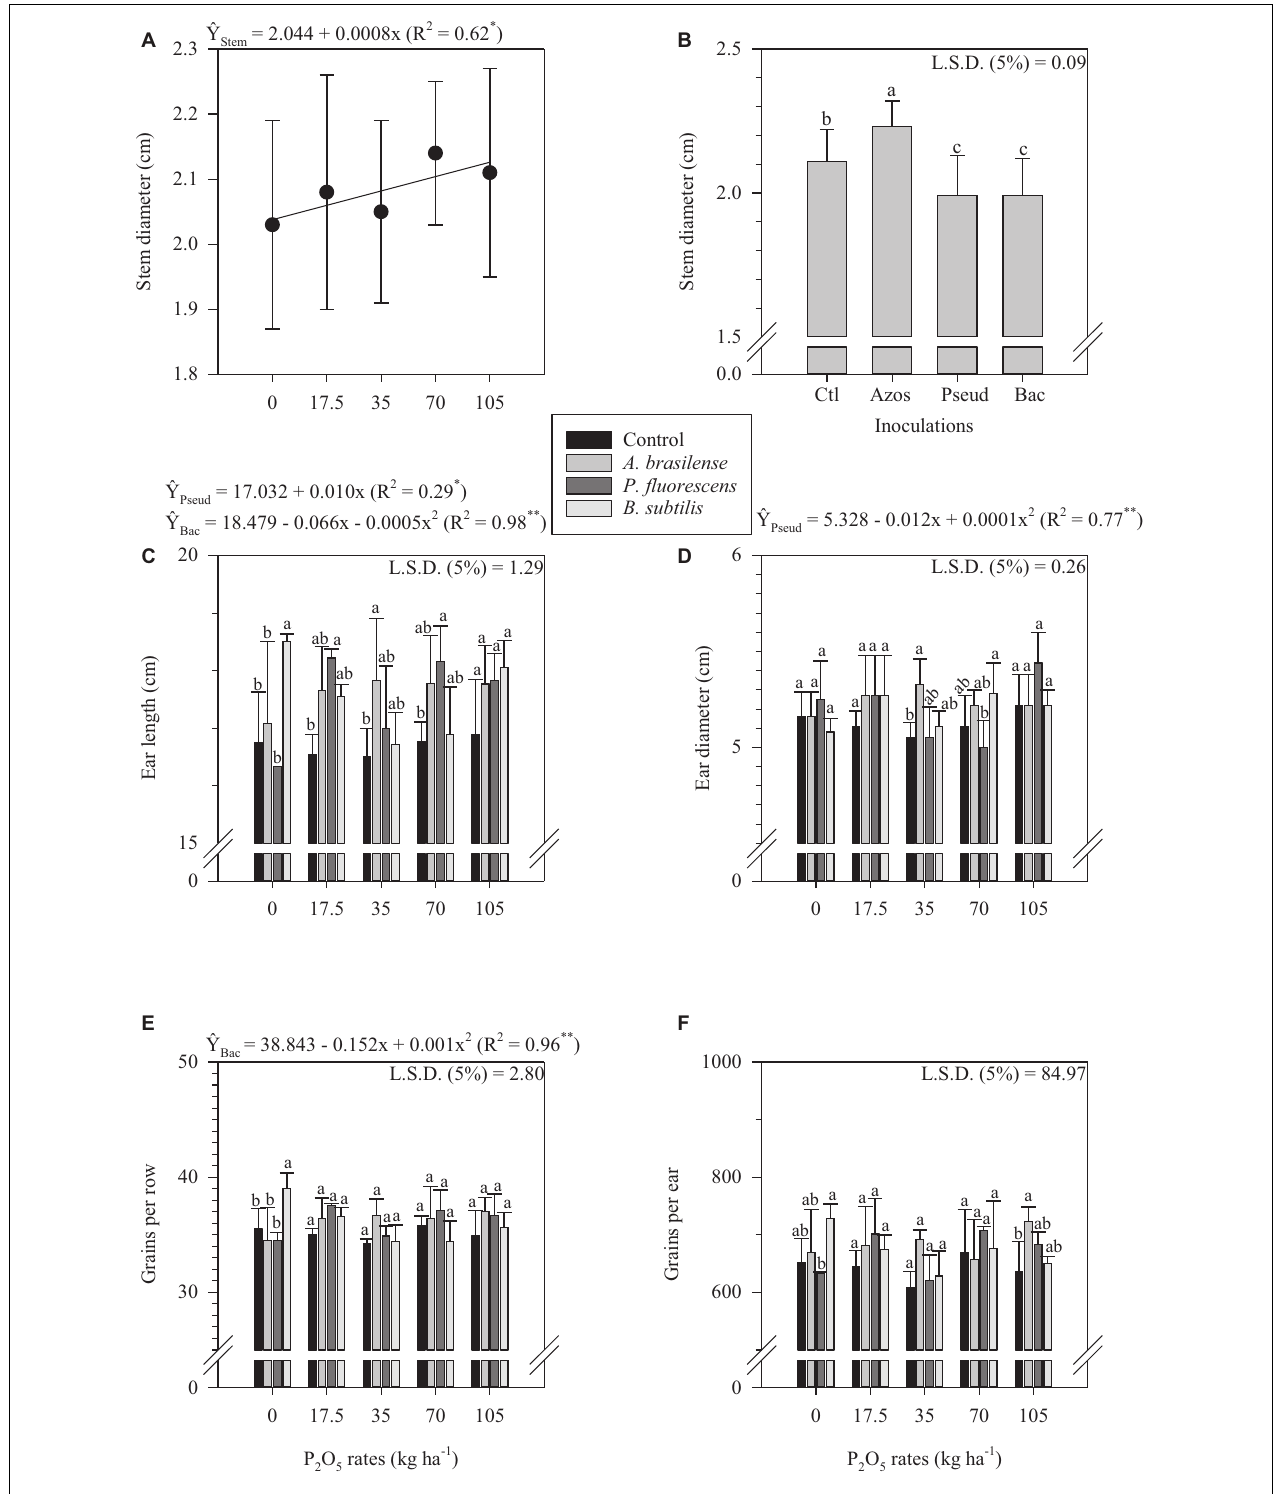
FIGURE 3 | Stem diameter as a function of P 2 O 5 rates (A) and inoculations (B) , ear length (C) , ear diameter (D) , grains per row (E) , and grains per ear (F) as a function of the interaction between P 2 O 5 rates and inoculations in corn crop. The letters correspond to a significant difference at 5% probability level ( p ≤ 0.05). Error bars indicate the standard deviation of the mean ( n = 4). Ctl, Azos, Pseud e Bac refers to the control treatment and inoculations with A. brasilense , P. fluorescens and B. subtilis , respectively. L.S.D. (least significant difference).